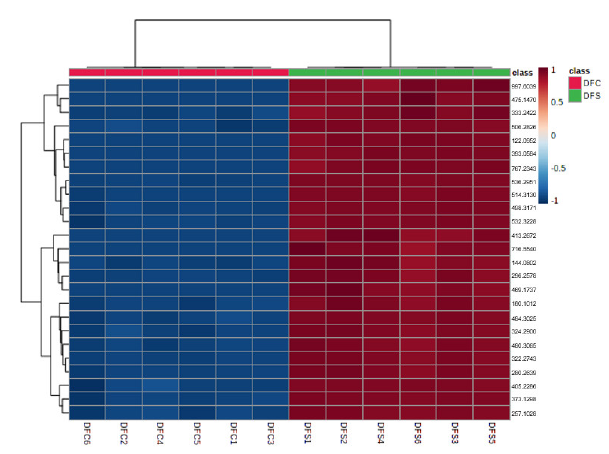
Figure 5. Heatmap overview showing the discriminations of DFC and DFS. The colour scale was set to default ranging from red (high) to blue (low).